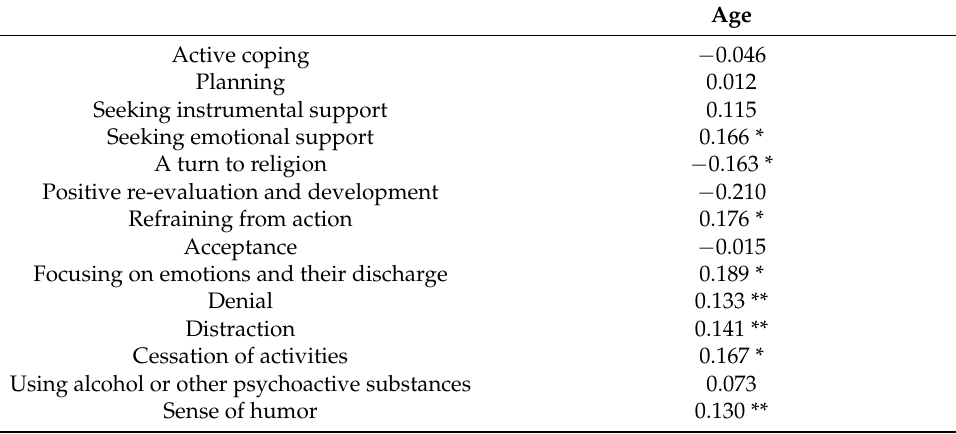
Table 10. Correlations between coping strategies and participant’s ages.